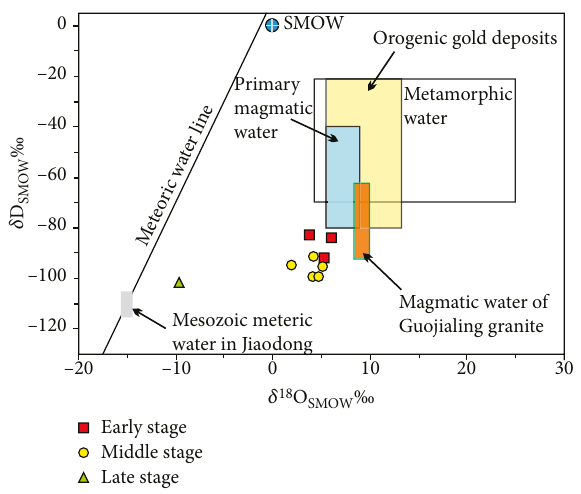
Figure 12: δ 18 O – δ D plots of the ore fl uids at the Xiejiagou gold deposit. The base map is cited from Taylor [74]. δ 18 O and δ D H2O values of the Mesozoic meteoric water in Jiaodong after Tan et al. [7]. δ 18 O and δ D values of the Magmatic water of Guojialing H2O granite after Guo et al. [76]. δ 18 O and δ D values of the H2O orogenic gold deposits revised after Goldfarb et al.